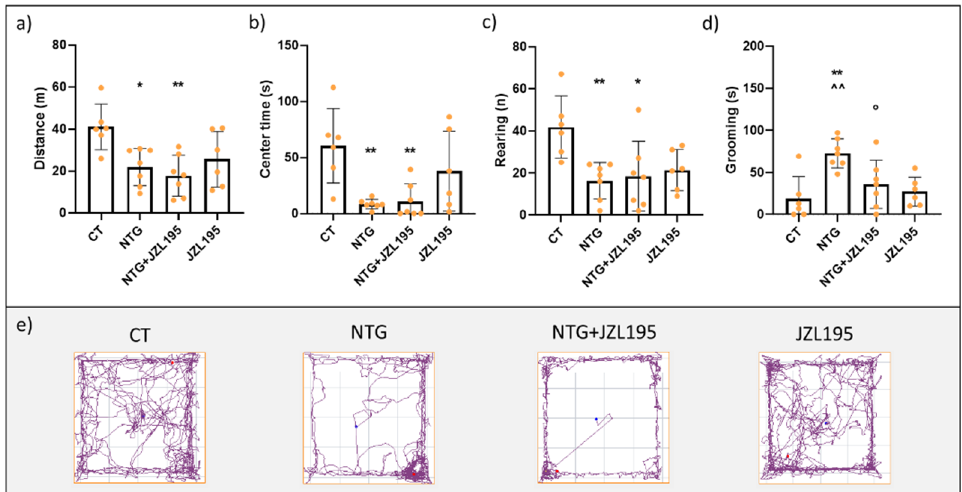
Figure 2. Open field test analysis. ( a ) Distance (expressed in meters) travelled in the apparatus; ( b ) time spent (expressed in seconds) in the center of the apparatus; ( c ) number of rearing; ( d ) time spent in grooming behavior (expressed in seconds); ( e ) representative track plots of the different experimental groups. Male Sprague–Dawley rats were treated with JZL195 at a dose of 3 mg/kg, dissolved in a volume of 2 mL/kg of vehicle (Tween-80/polyethylene glycol 200/saline), 2 h after NTG or vehicle injection. The locomotor activity, anxiety, and different types of behaviors were evaluated 4 h after NTG or vehicle injection. Data are expressed as mean ± SD. One-way ANOVA followed by Tukey’s multiple comparisons test; * p < 0.05 and ** p < 0.01 vs. CT; ^^ p < 0.05 vs. JZL195; ° p < 0.05 vs. NTG. CT: control group ( n = 6); NTG: nitroglycerin group ( n = 7); NTG + JZL195: nitro-